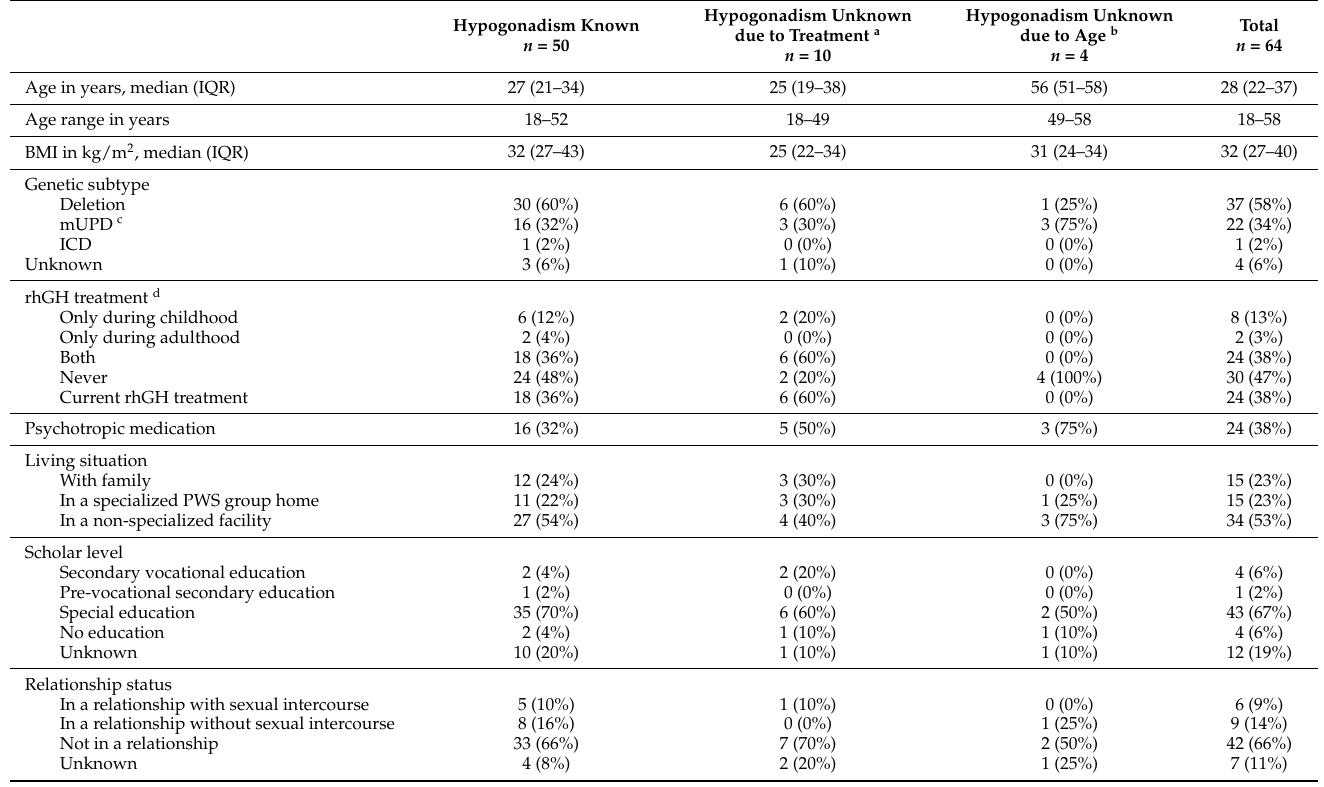
Table 1. Baseline characteristics of 64 females with Prader-Willi